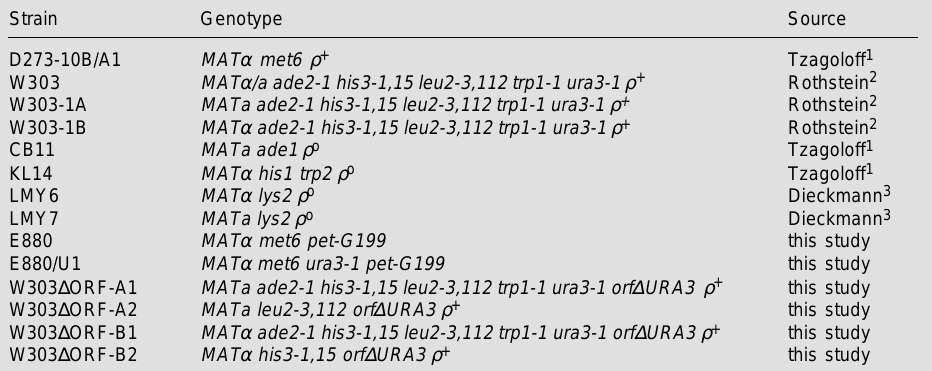
Table 1 - Saccharomyces cerevisiae strains